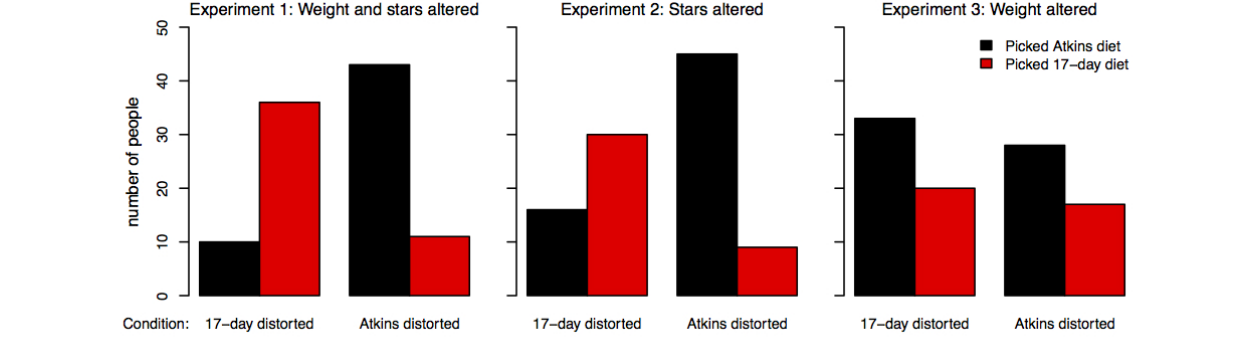
Figure 4. Experiment 1 indicates participants prefer diet book with positive reviews and large weight loss over diet with positivity and weight change more representative of clinical trial results. Experiments 2 and 3 indicate that positivity alone but not weight change alone influence